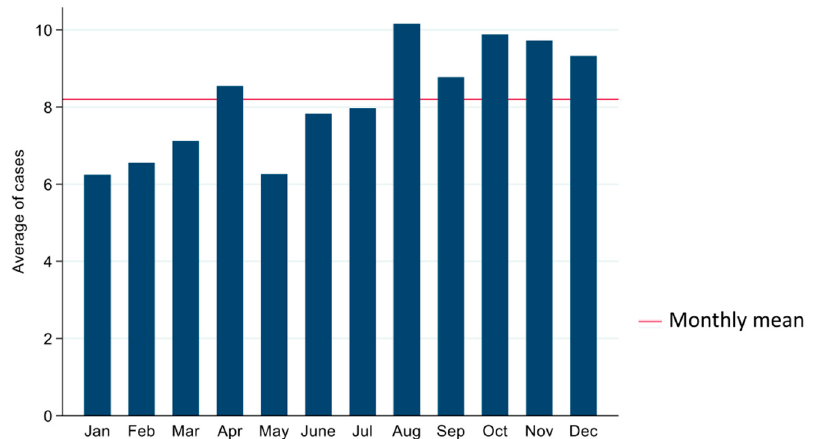
Figure 2. Monthly frequency of cases submitted to the AVC ADSBL from 2000 to 2021 (up until April) for bacterial culture and isolation.